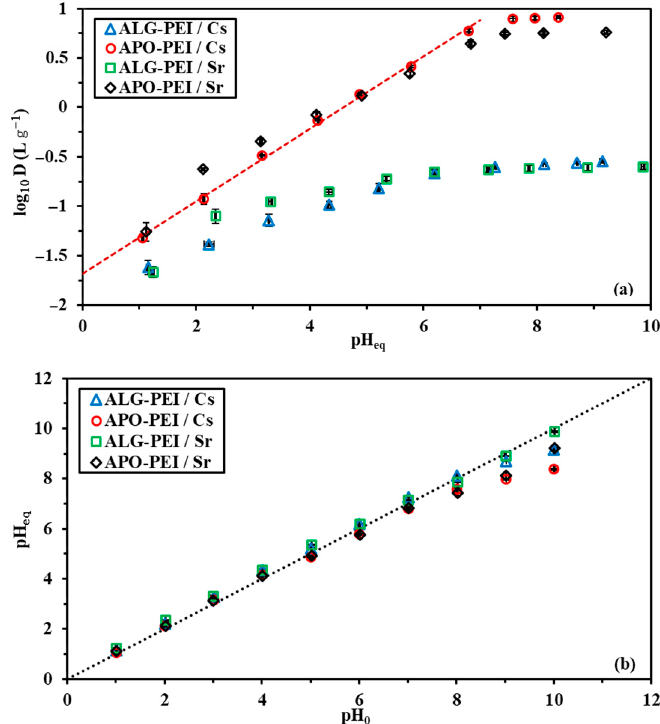
Figure A10. Effect of pH on Cs(I) and Sr(II) sorption: ( a ) log 10 D vs. pH eq plot and ( b ) pH variation during metal sorption for ALG-PEI and APO-PEI sorbents (C 0 : 0.802 mmol Cs L − 1 or 2.128 mmol Sr L − 1 ; sorbent dose, SD: 0.67 g L − 1 ; v: 210 rpm; time: 48 h; T: 21 ± 1 °C).